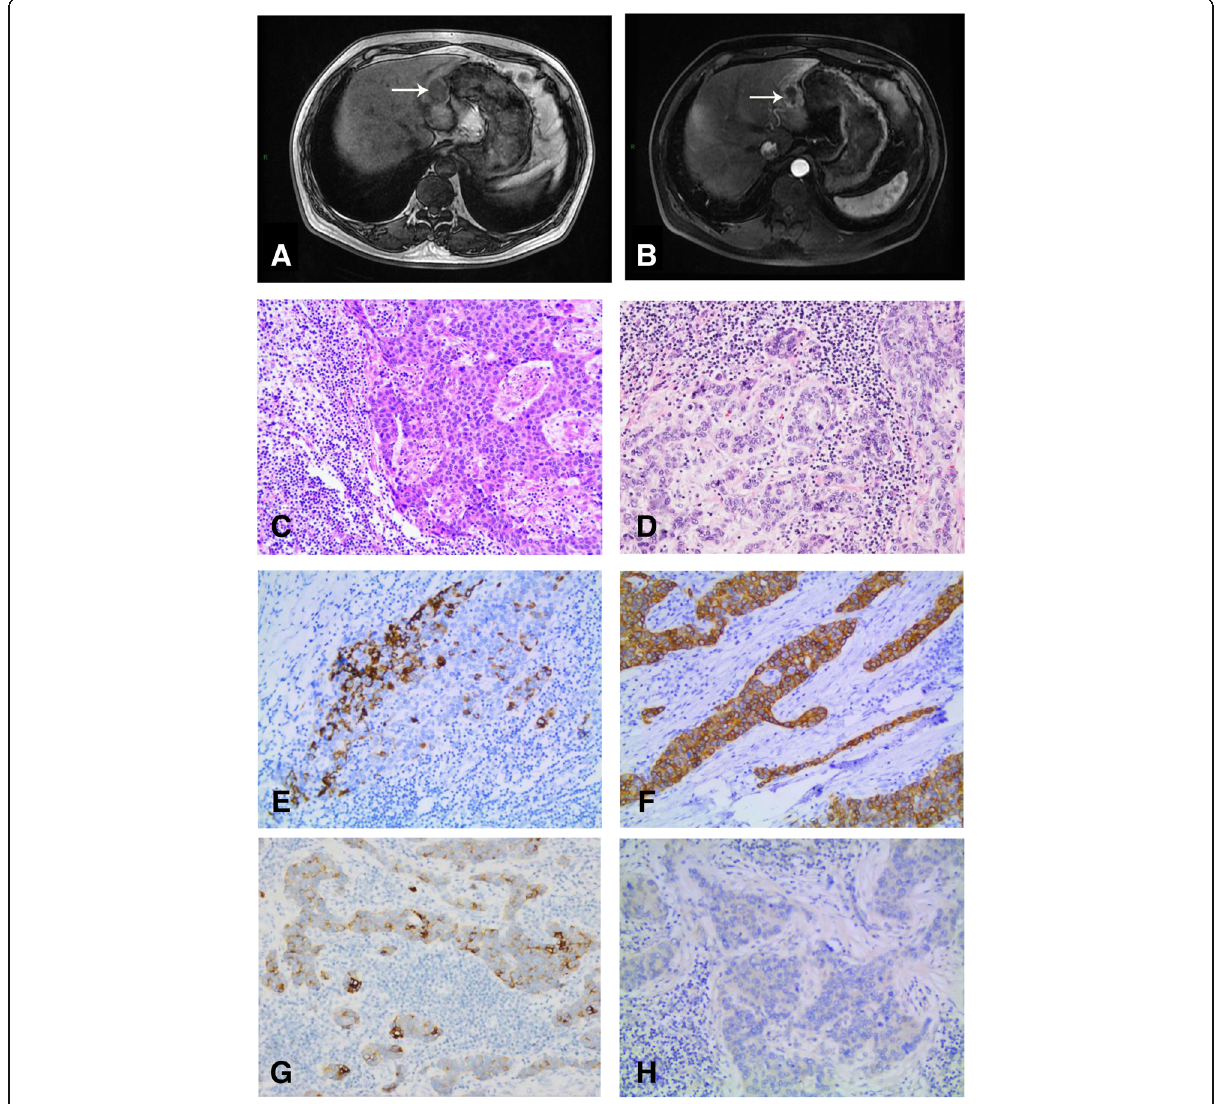
Fig. 2 Preoperative MRI findings and microscopic findings of the resected specimen. MRI showing a space-occupying lesion of approximately 3.2 × 2.5 cm in left lateral lobe, hypointense on T1-weighted images ( a ), enhancement in arterial phase ( b ). Tumor is composed of poorly differentiated cells admixed with significant lymphocytic infifiltrates ( c , HE, × 200). Histological findings showing glandular differentiation ( d , HE, × 200). Immunohistochemical staining for hepatocyte, CK18, CK19 is positive ( e , HE, × 200), ( f , HE, × 200), ( g , HE, × 200). Immunohistochemical staining for EBER is negative ( h , HE, ×